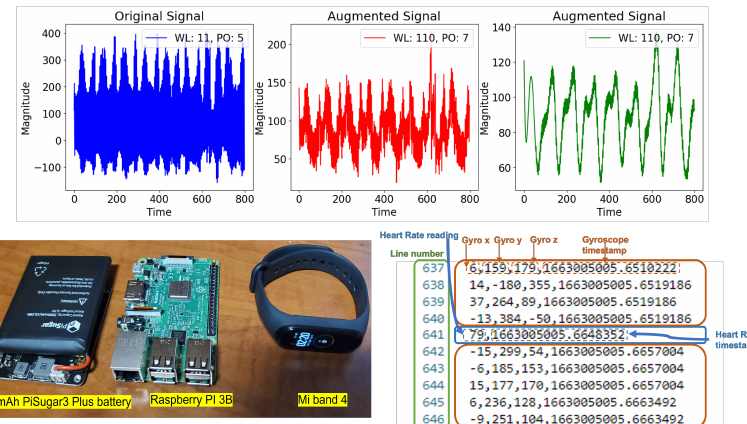
Figure 3. ( Top ) From left to right: Raw signal from the self-collected HARB dataset. An augmented version of the raw signal using a Sav–Gol filter using a window length of 11 and a polynomial order of 5. An augmented version of the raw signal using a Sav–Gol filter with a window length of 110 and a polynomial order of 7. The goal of augmentation is to balance the dataset. ( Bottom ) Right: Human Activity Recognition with fitness Band (HARB) dataset sample file format; ( Bottom ) Left Data collection